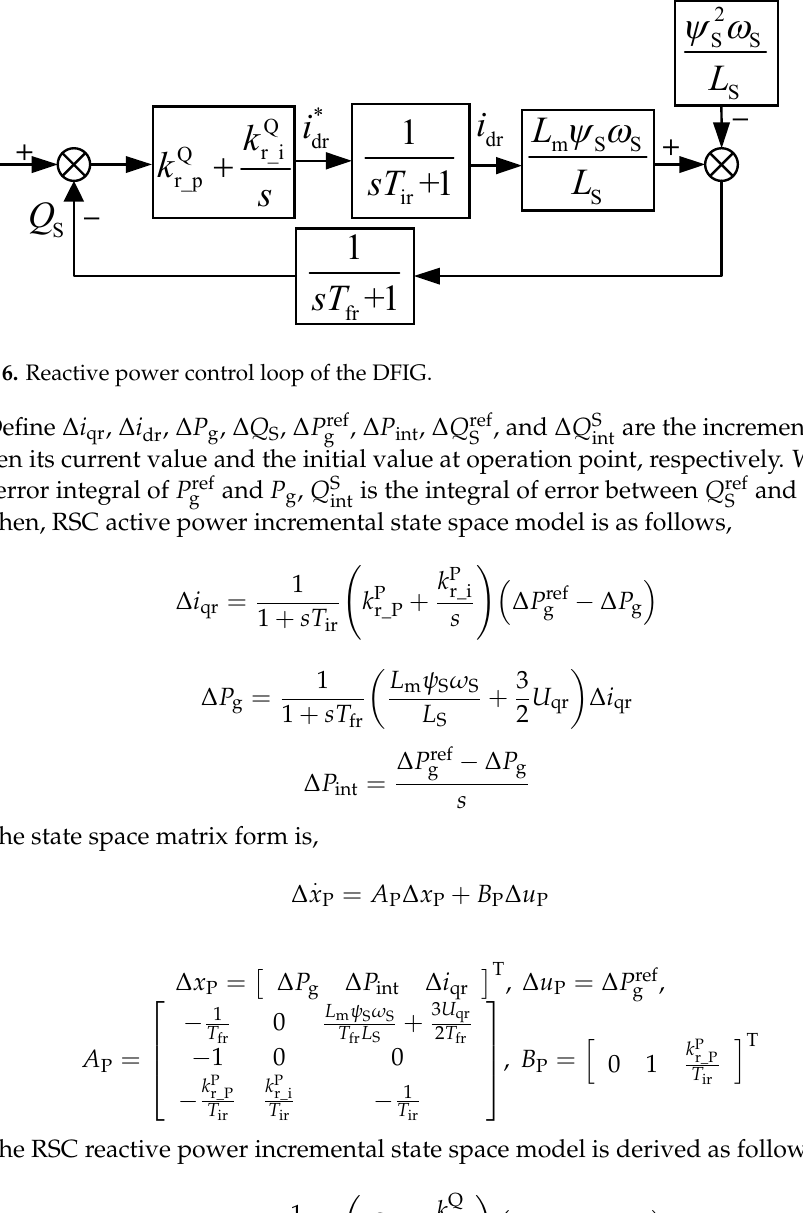
Figure 5. Active power control loop of the DFIG.